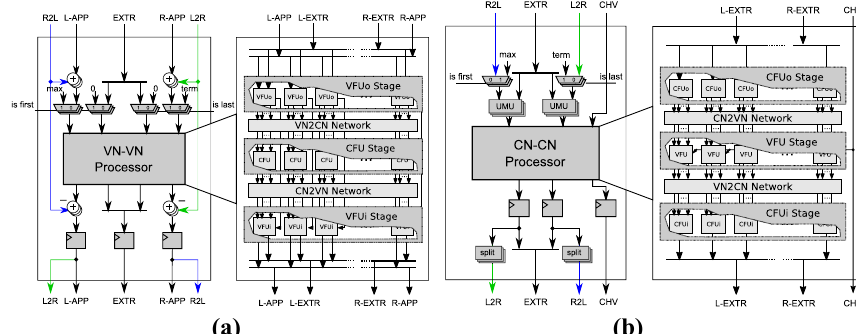
Fig. 3 Architectures for row- and column-wise iteration